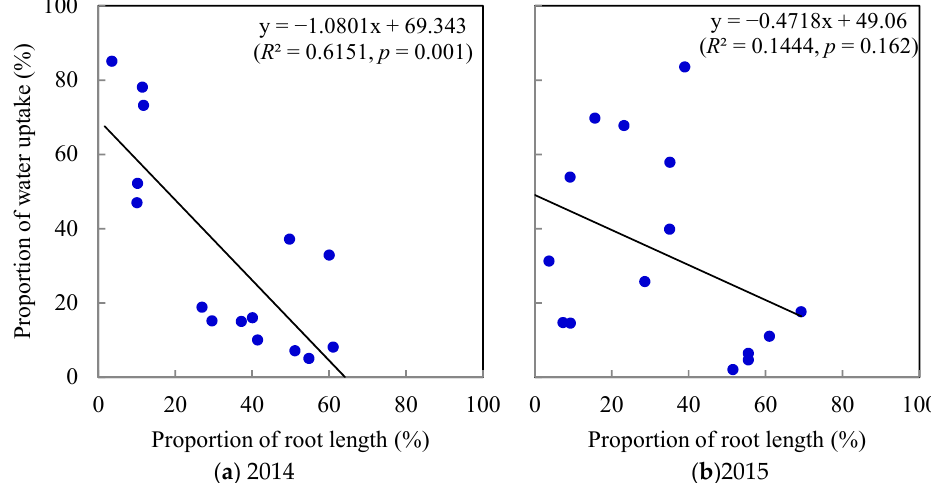
Figure 8. Relationship between the water uptake proportions and proportions of root length in the ( a ) 2014 and ( b ) 2015 seasons.